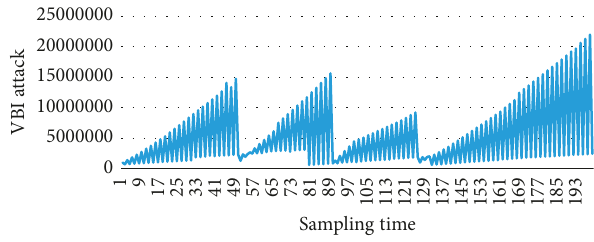
Figure 17: Feature of VBI for attack traffics.